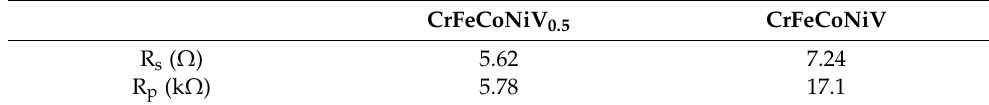
Figure 4. Electrochemical impedance spectroscopy measurements of as-cast CrFeCoNiV x alloys in 1M H 2 SO 4 solution: ( a ) Nyquist plots; ( b ) Bode plots; ( c ) corresponding equivalent circuit diagrams. R s is the solution resistance; R p is the polarization resistance; CPE is the constant phase element; W is the Warburg impedance. Table 4. The resistances of as-cast CoCrFeNiV x alloys in deaerated 1M H 2 SO 4